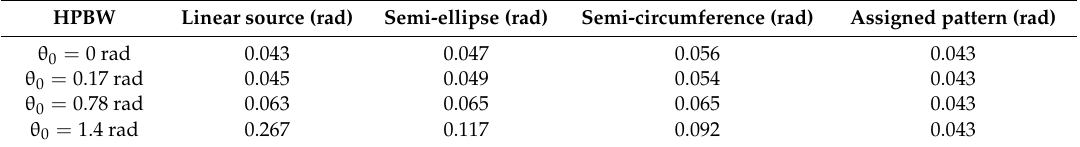
semi-elliptical, and semi-circumference source, varying the main beam angle θ 0 .